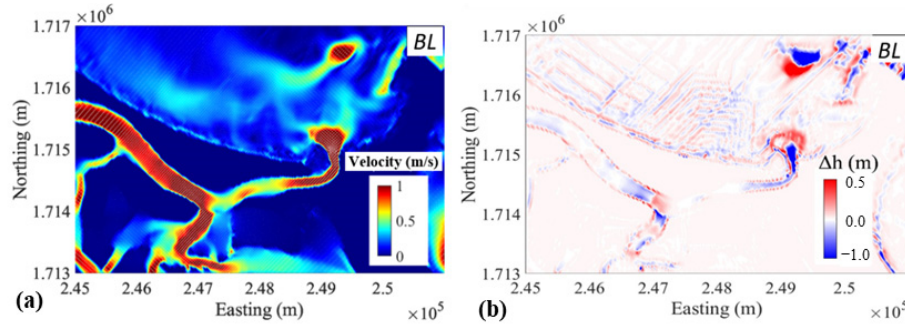
Figure 16. ( a ) Current field, ( b ) bed level changes in the area of Cua Lo after the flood event—BL scenario.